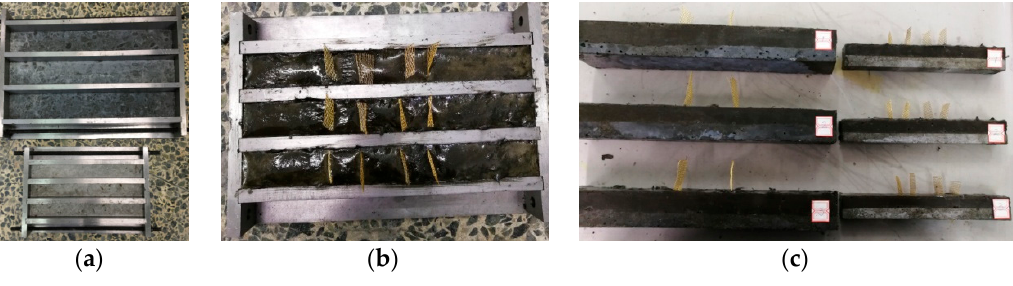
Figure 2. Sample pouring process. ( a ) Cast-in-place specimen;( b ) insertion of electrode; ( c )